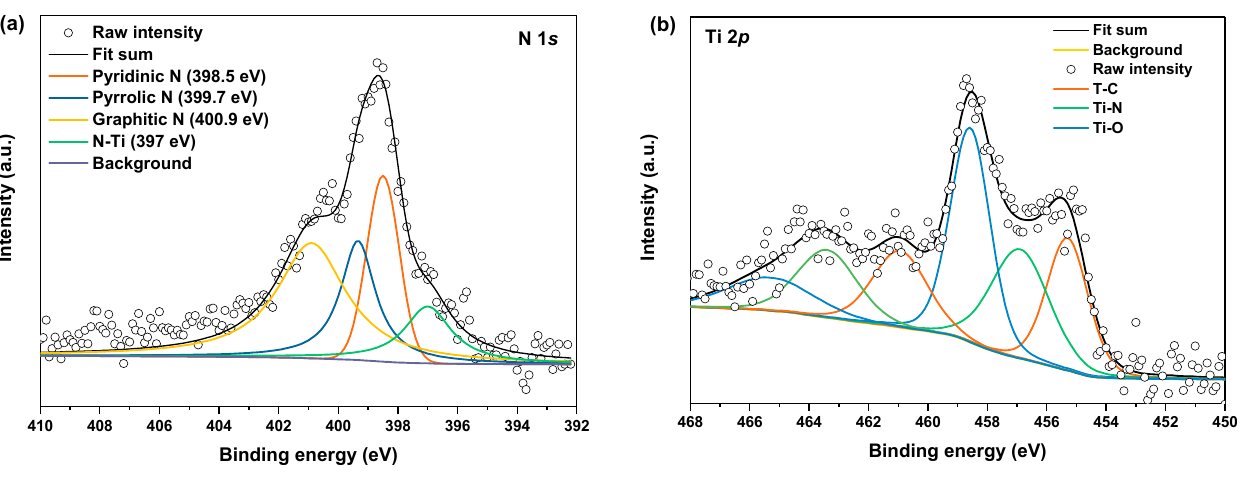
of the N-M@CNi separator is due to its adsorption effect that effectively inhibits the loss Figure 3. The deconvoluted XPS of ( a ) N 1 s and ( b ) Ti 2 p of the N-M@CNi sample. of the LiPS.